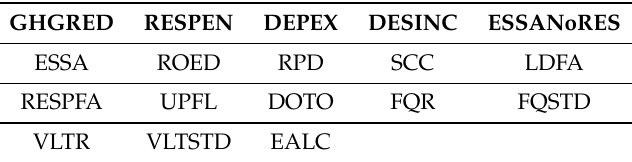
Table 1. KPIs that were used in the